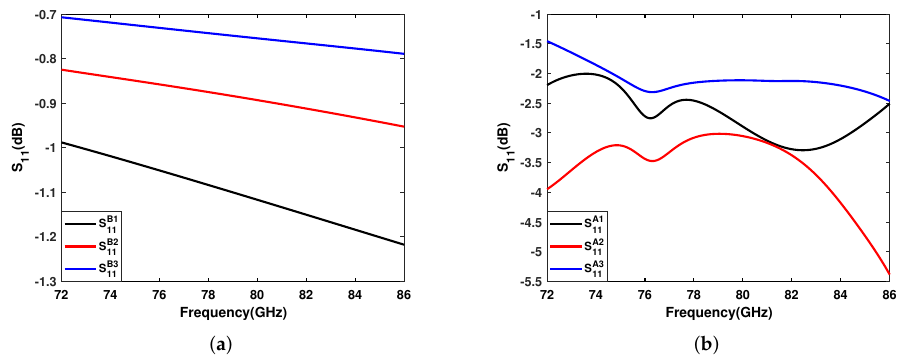
Figure 13. Simulated S 11 ( a ) at reference plane B, ( b ) at reference plane